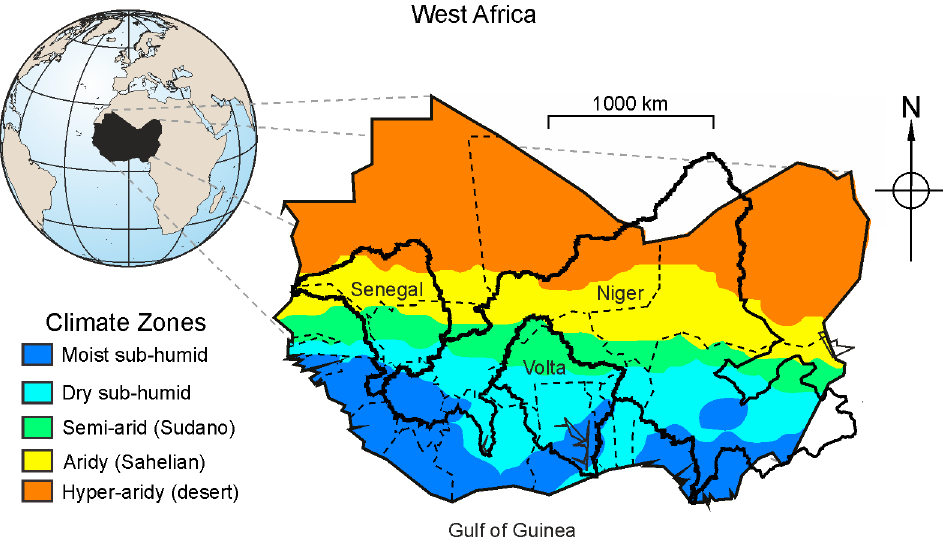
Figure 1. The study area of West Africa and its major river basins (Niger, Senegal, and Volta) in black ‐ solid lines. The dashed lines show the countries of West Africa. The scale refers to the center of the map. The climate zones were classified as suggested by Andam ‐ Akorful et al. [24].